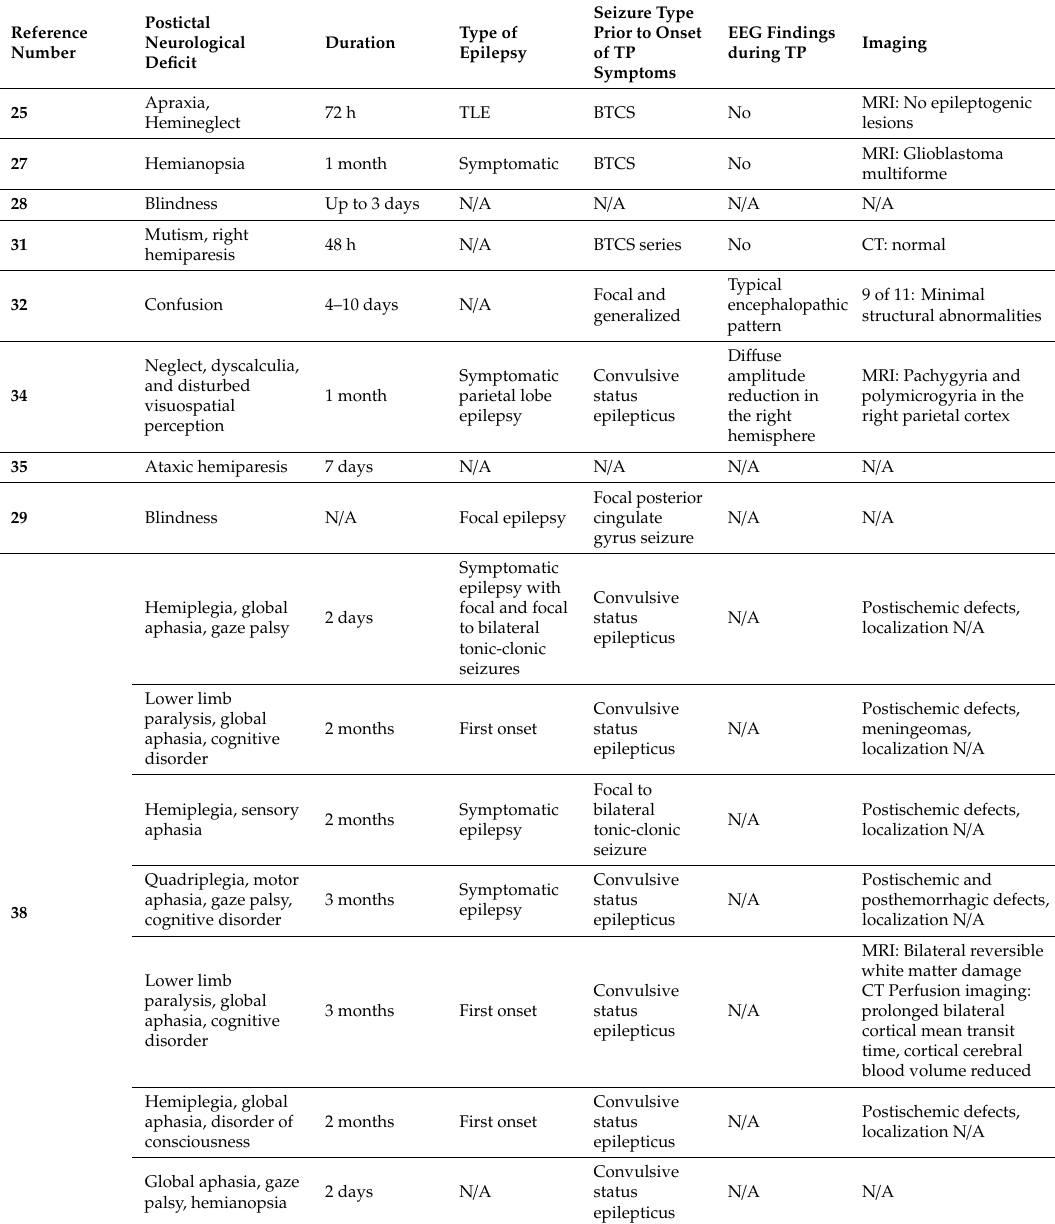
Table 1. Case report